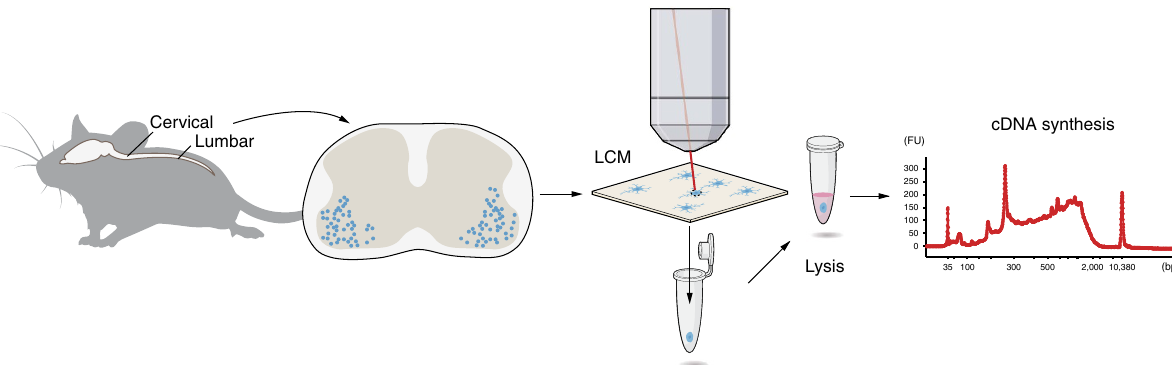
Figure 1 | Schematics of Smart-seq2 coupled with LCM (LCM-seq) for analysis of single neurons. Spinal cords isolated from mouse pups were sectioned at 12 m m thickness at cervical and lumbar levels. MNs were visualized using Histogene staining, 120, 50, 30, 10, 5, 2 and 1 cell captured by a Leica LMD7000 system and collected in PCR tubes. Cells were lysed, cDNA synthesized, amplified and analysed using a Bioanalyzer and sequencing